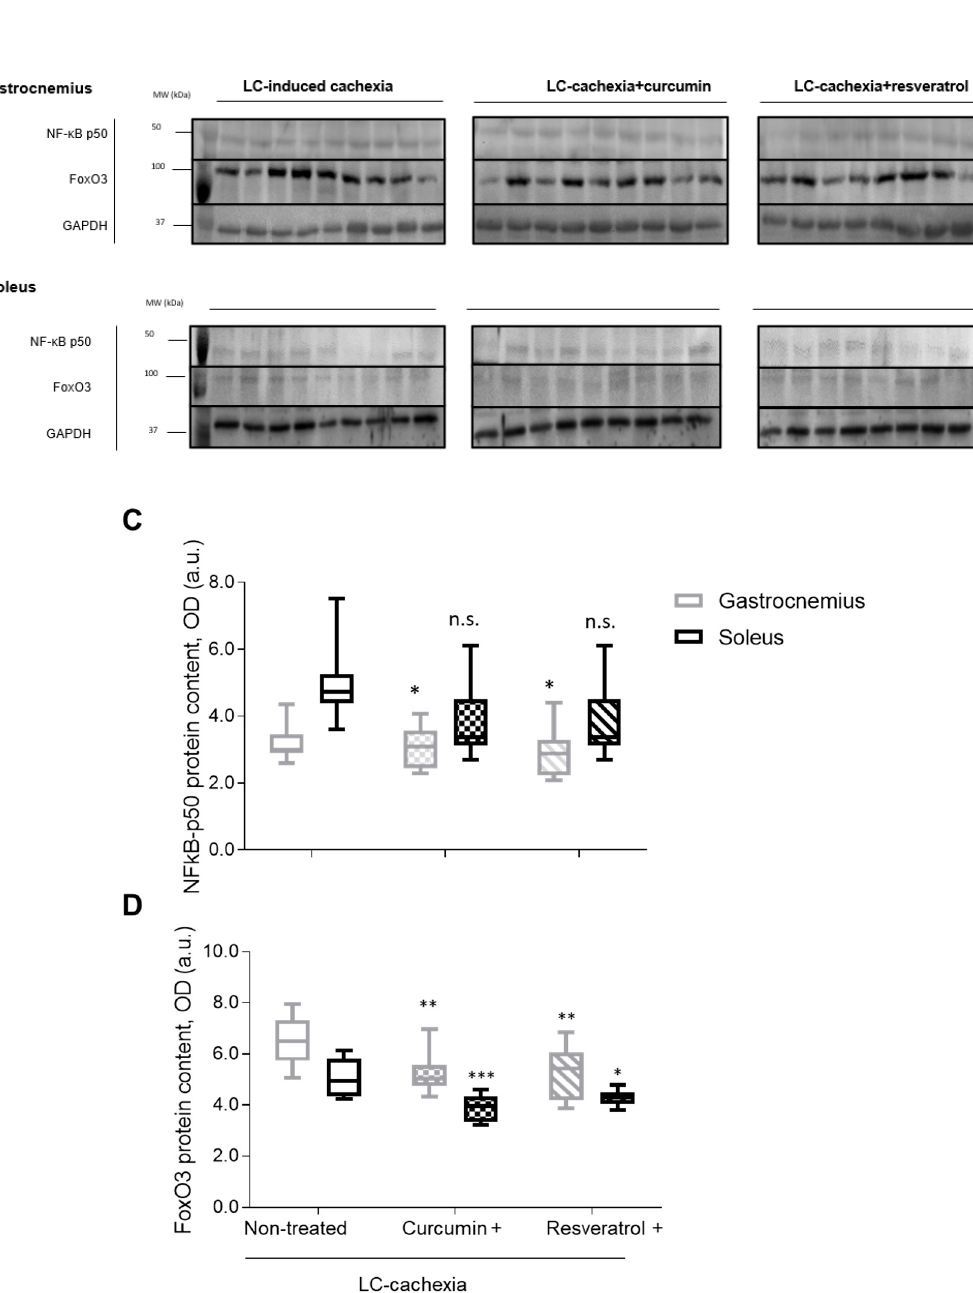
Figure 8. Representative immunoblots of NF- κ B p50, FoxO3, and GAPDH protein content in the gastrocnemius ( A ) and soleus ( B ) muscles of all study groups of mice. Box plots of Nf- κ B p50 ( C ) and FoxO3 ( D ) protein content in gastrocnemius and soleus muscles of the different study groups of mice, as measured by optical densities in arbitrary units (OD,